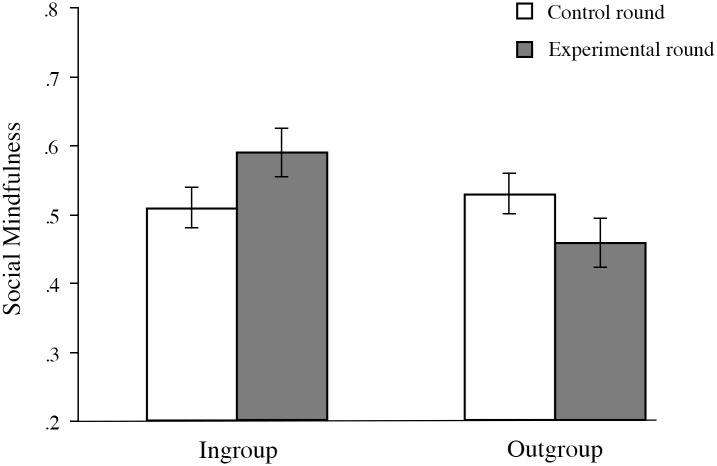
Mean scores on social mindfulness in Study 2.Error bars represent standard error.